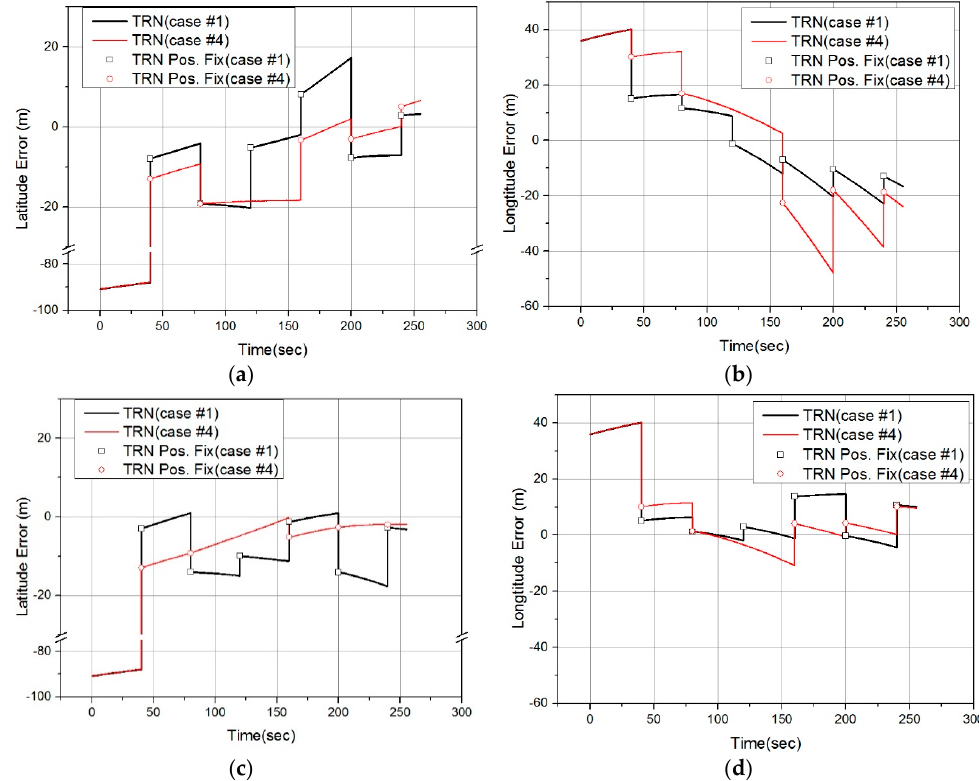
Figure 18. TRN simulation result graphs: ( a ) latitude error for Conventional method; ( b ) longitude error for Conventional method; ( c ) latitude error for Proposed method; ( d ) longitude error for Proposed method.